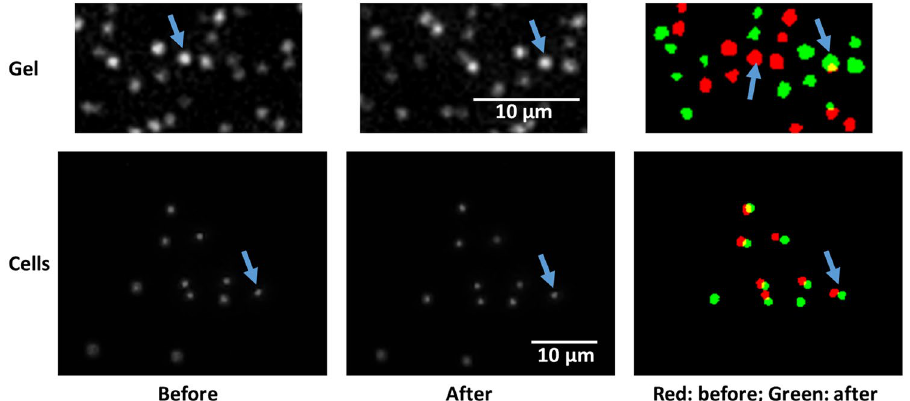
Figure 3. Examples of bead positions before and during flow. Bead positions and displacements due to shear stress on polyacrylamide gel (top row) and endothelial cells (bottom row). The left and middle columns correspond to bead positions before and after application of shear stress. The gel and the cells were exposed to a shear stress of 5.8 and 2.9 Pa, respectively. Notice the much larger displacements on the gel due to the ~100 times larger thickness of the sample. The right column demonstrates the identification of beads and their displacements. The red and green beads correspond to before and after shear stress conditions. The blue arrows follow a single bead through the